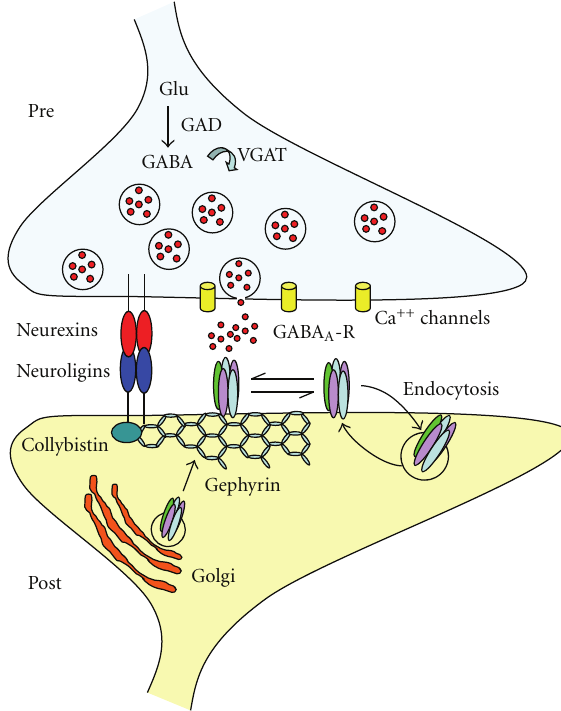
Figure 3: Structural organization of GABAergic synapses. The postsynaptic organization comprises a large number of proteins that allow the correct targeting, clustering and stabilization of GABA A receptors. Among them gephyrin forms hexagonal lattices that trap GABA A receptors in precise apposition to presynaptic release sites. Cell adhesion molecules of the neuroligin-neurexin families bridge the cleft and ensure transsynaptic signaling, essential for the maintenance of a proper E/I